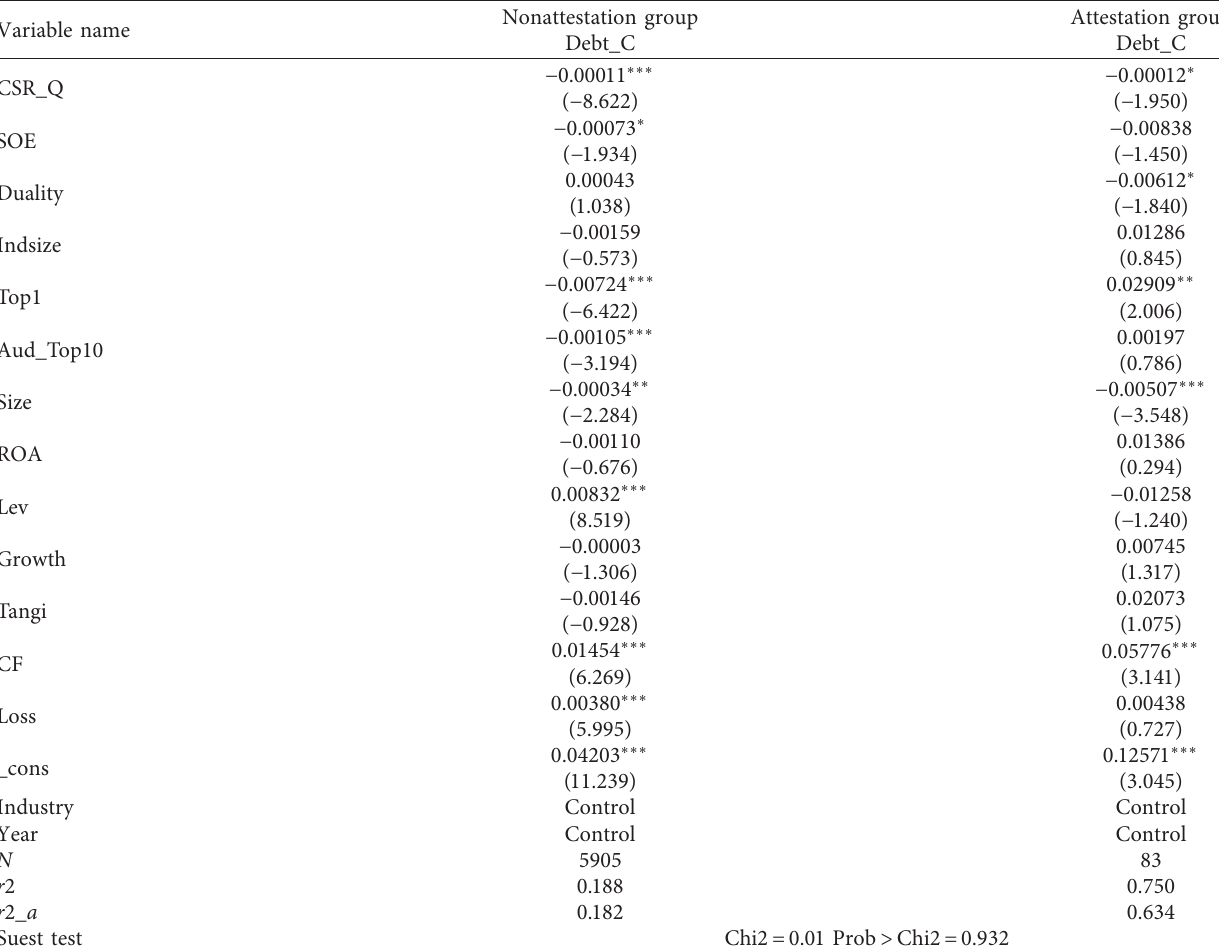
Table 7: Quality of social responsibility disclosure and cost of debt financing: based on forensic effect